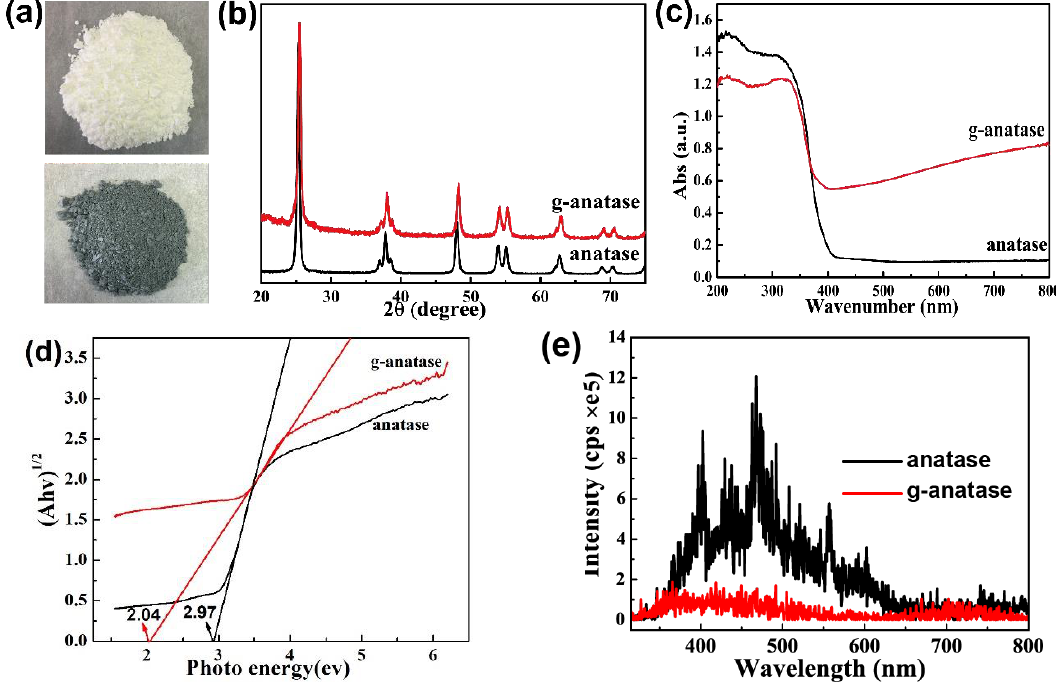
Figure 2. ( a ) Images of anatase (top) and colored anatase (bottom), ( b ) XRD patterns, ( c ) diffuse reflectance UV-Vis spectra, ( d ) relationship between (Ahν) 1/2 and hν and ( e ) photoluminescence (PL) spectra of anatase and colored anatase.